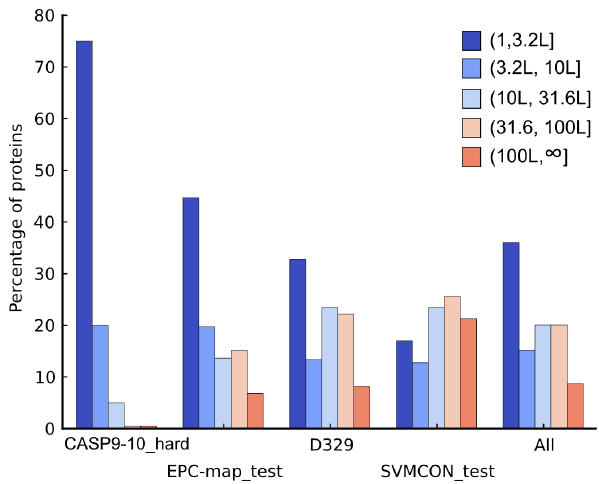
Figure 5. Alignment depth composition of the CASP9-10_hard, EPC-map_test, D329 and SVMCON_test data sets. Proteins are grouped into bins based on their number of sequences in the alignment. Colors correspond to a particular bin, from dark blue (few sequences) to red (many sequences). Data sets are sorted from difficult (CASP9-10_hard) to easy (SVMCON_test). The last panel shows the pooled results. (Counting) and machine-learning based methods (NNcon, PhyC-